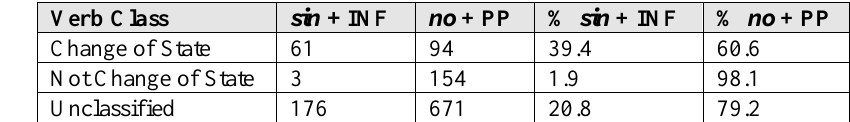
Table 5. Frequency of adjectival sin + INF and no + PP by verb class